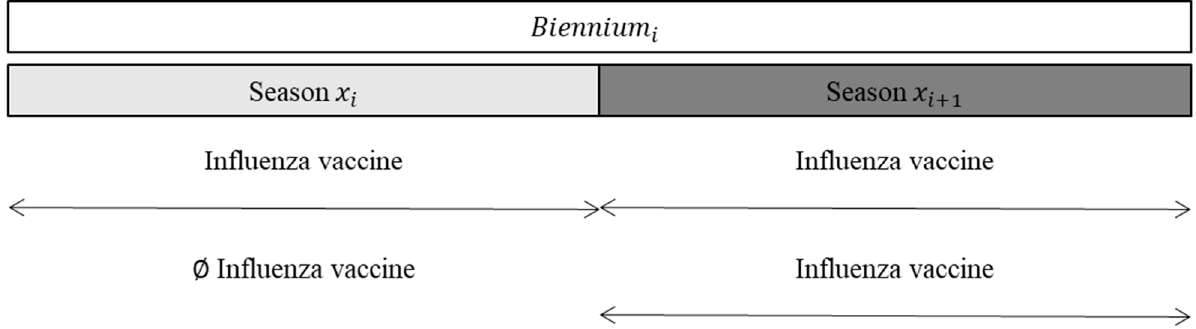
Figure 1. Definition of exposure to assess the additive effect of the influenza vaccine repeated in at least two consecutive seasons.